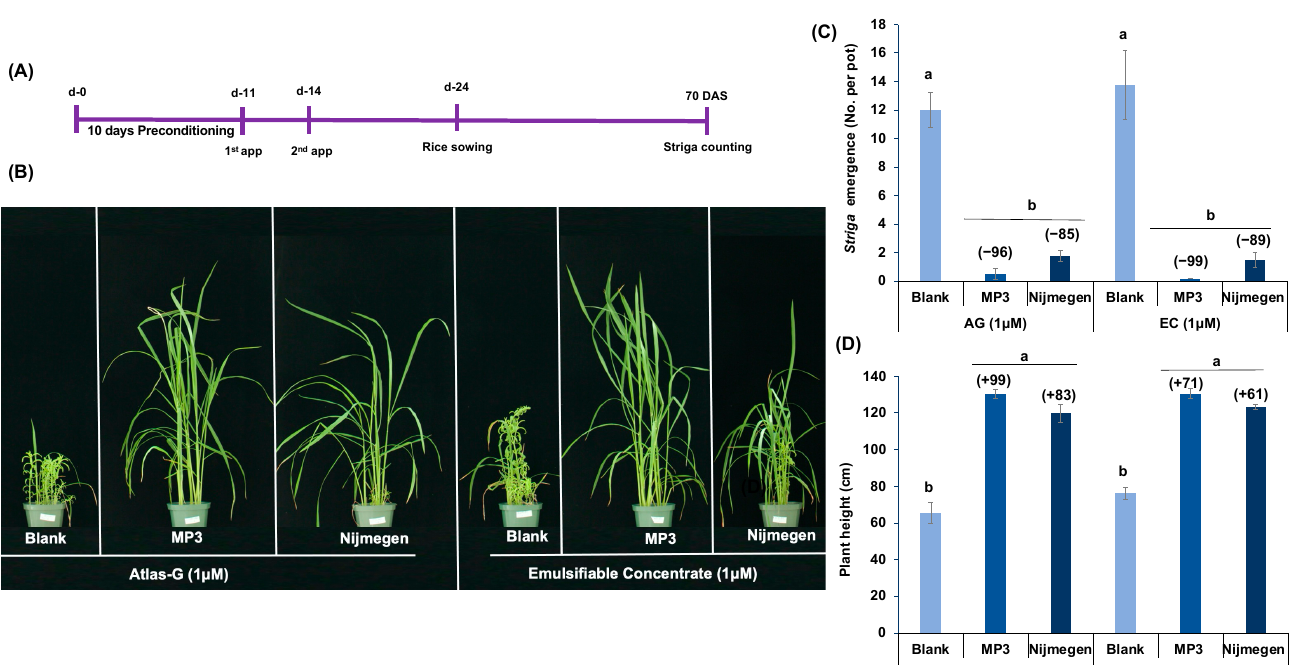
Figure 5. Effect of various formulations of strigolactone analogs on Striga emergence in pots under greenhouse conditions. ( A ) Scheme of the experiment conducted for Striga emergence in pots under greenhouse conditions. ( B ) View of the Striga infected pots. Each pot was filled with the soil infested with Striga seeds, collected from a sorghum field in Sudan. Both formulations of the two SL analogs (at 1.0 µM) were applied for two times in Striga infested pots. Striga emergence was counted at 70 days after sowing of rice. ( C ) Values of each bar showed average emergence of Striga per plot. ( D ) Average plant height of rice host plant measured at 70 DAS. Data are means ± SE ( n = 4). For each SL analog, treatments with various letters differ significantly ( p < 0.05). Values in parenthesis are showing the percentage increase (+) or decrease ( − ) over blank treatment.